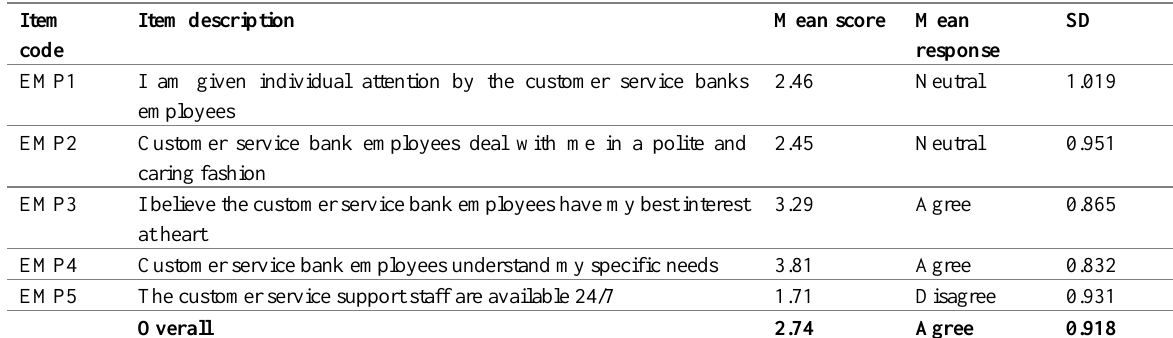
Table 6: Descriptive Statistics for Empathy